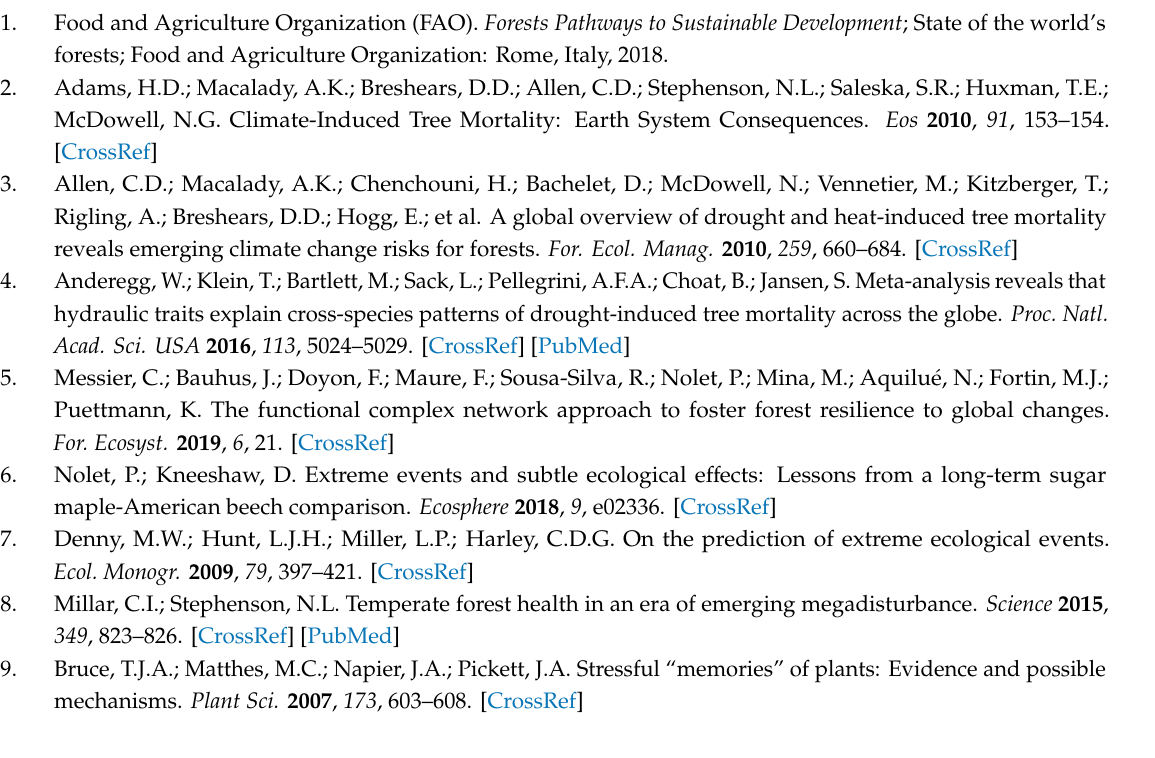
Table S1: Current state of epigenetics in trees for development, abiotic stress or priming, biotic stress or priming, and markers, breeding and biotechnology